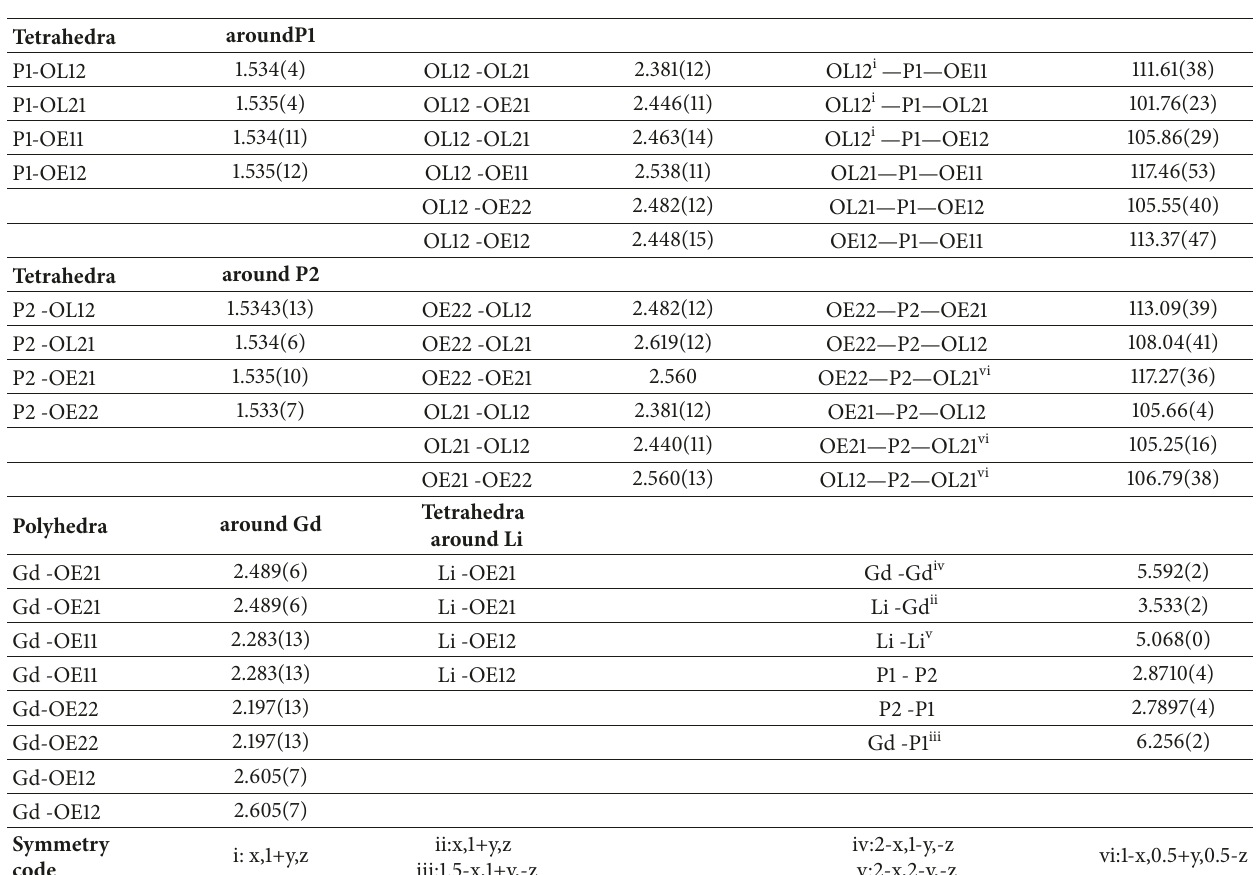
Table 2: Atomic distances(˚A) and angles in LiGd(PO 3 ) 4 with standard deviations in parentheses.